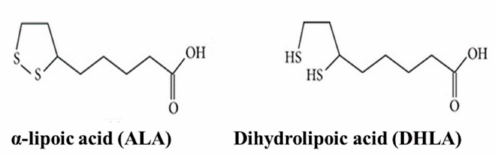
Figure 1. Structures of α -lipoic acid (ALA) and dihydrolipoic acid